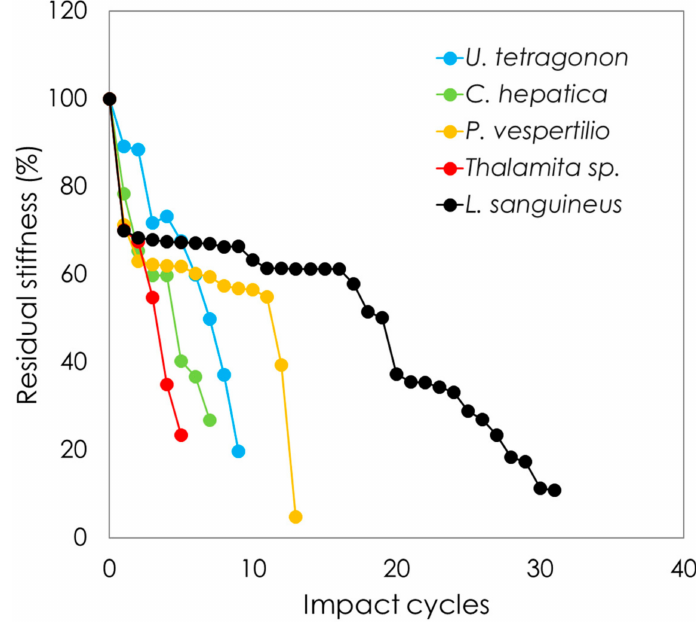
Figure 8. Carapace residual sti ff ness plotted against the number of impact cycles for each crab species (Note: Thalamita sp. grouped by genus; C. hepatica tested at 15.45 mJ after 500 impacts at 1.7 mJ and no loss in sti ff ness; all other species tested at 1.7 mJ).